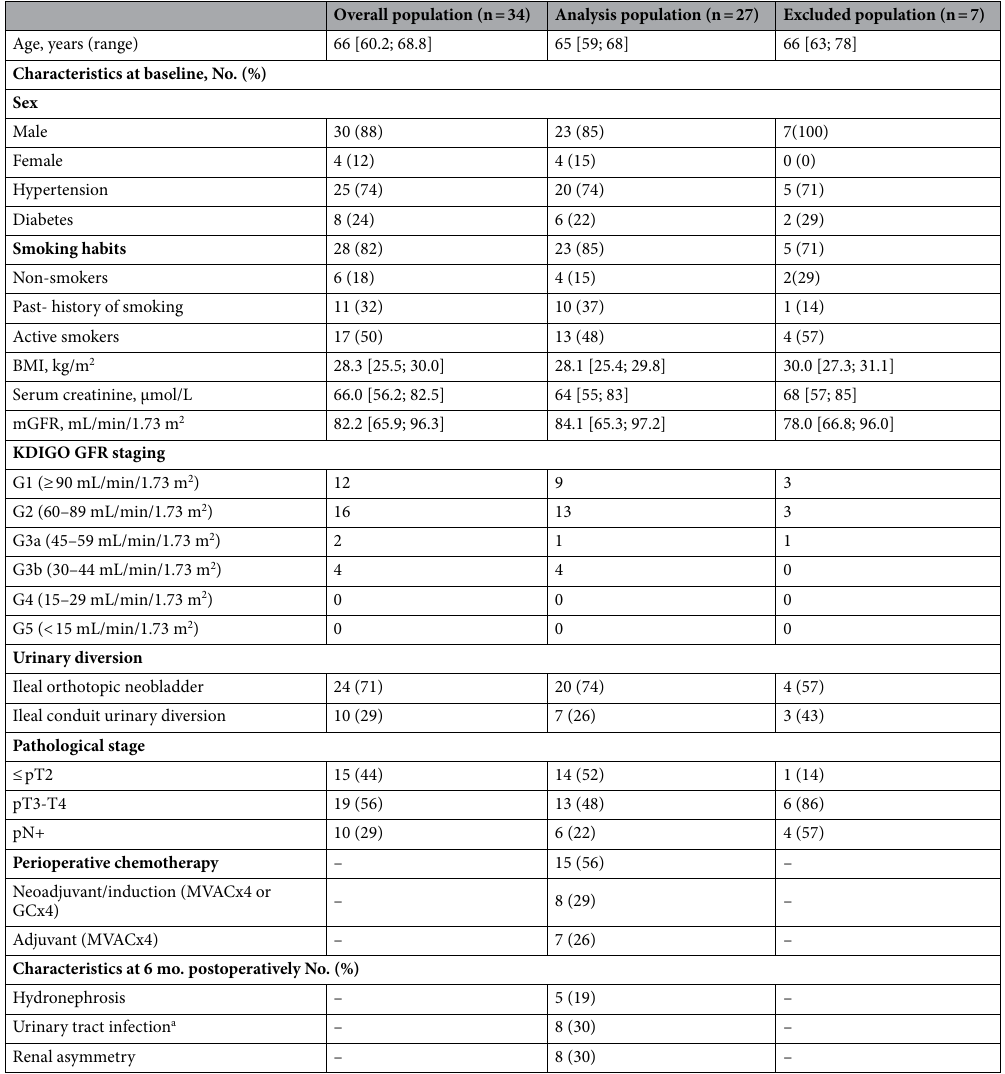
Table 1. Patients characteristics at baseline for overall population, excluded population, and analysis population at baseline and 6 months postoperatively. Continuous variables: median [IQR];